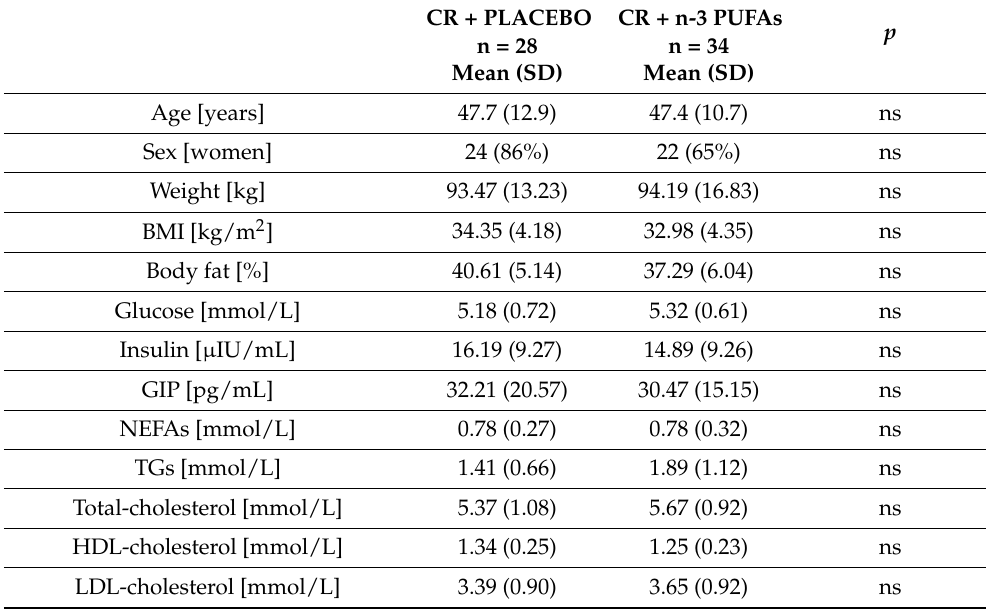
Table 1. Characteristics of participants at